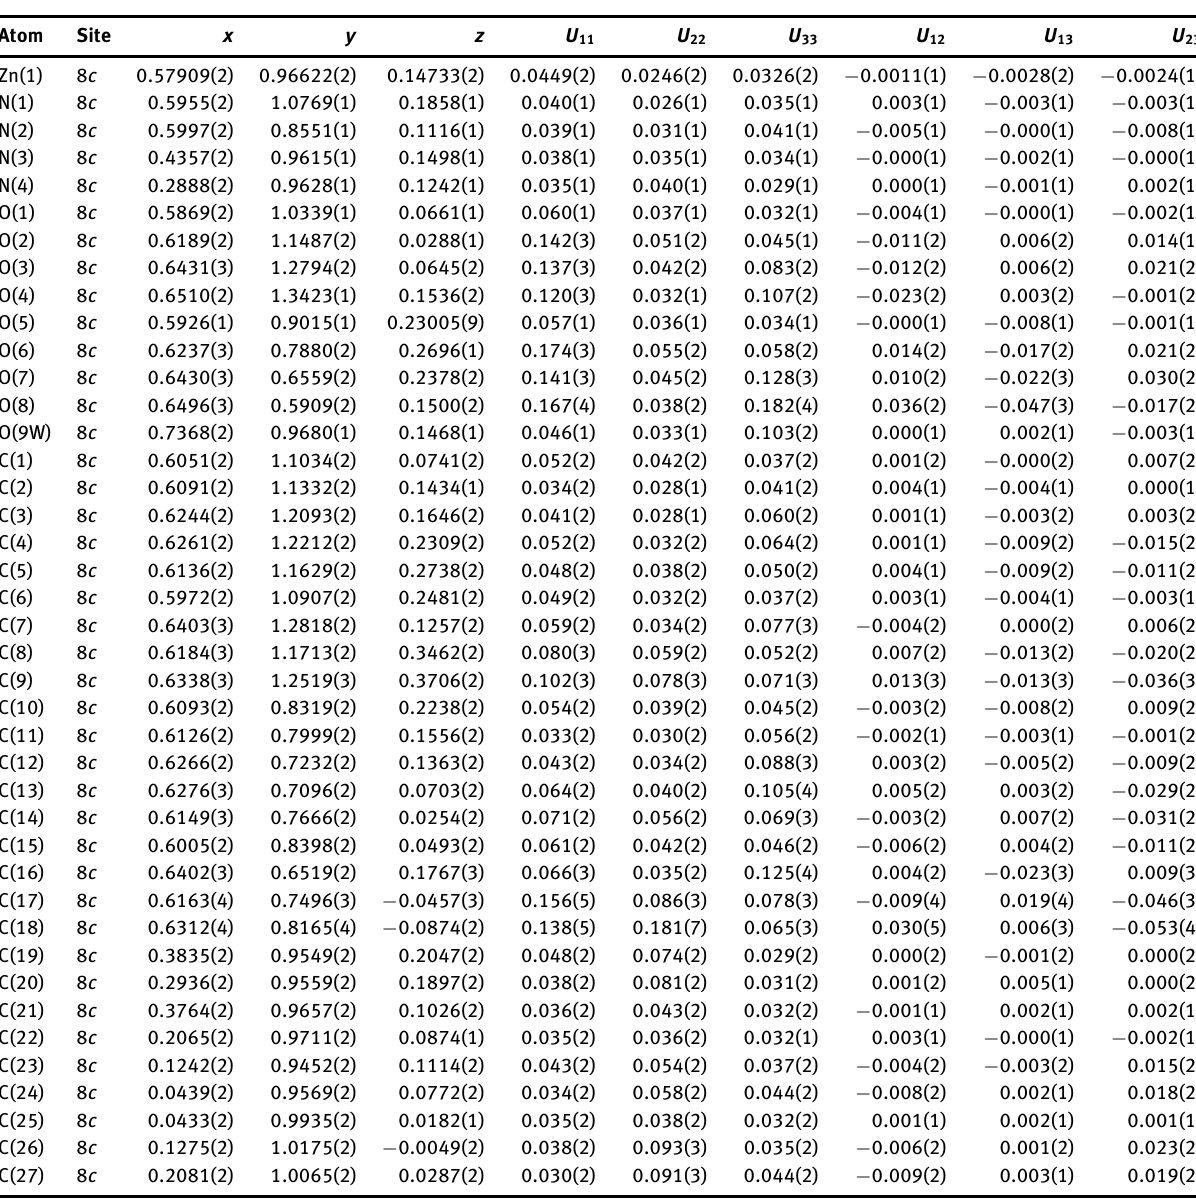
Table 3: Atomic displacement parameters (Å 2